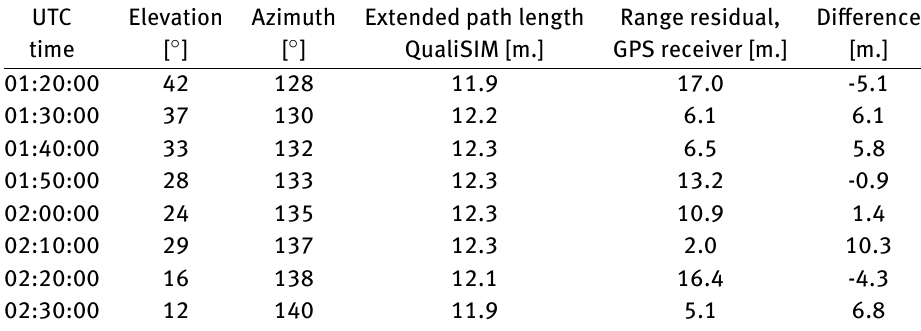
Table 2: Extended path length compared to range residual